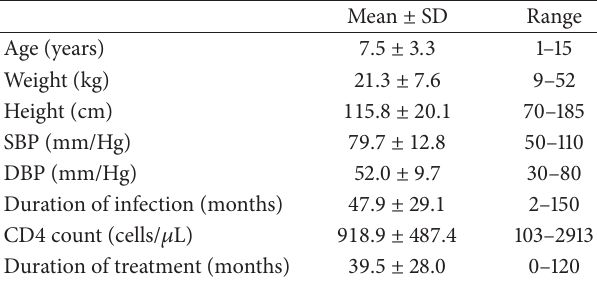
Table 2: Descriptive statistics of the study